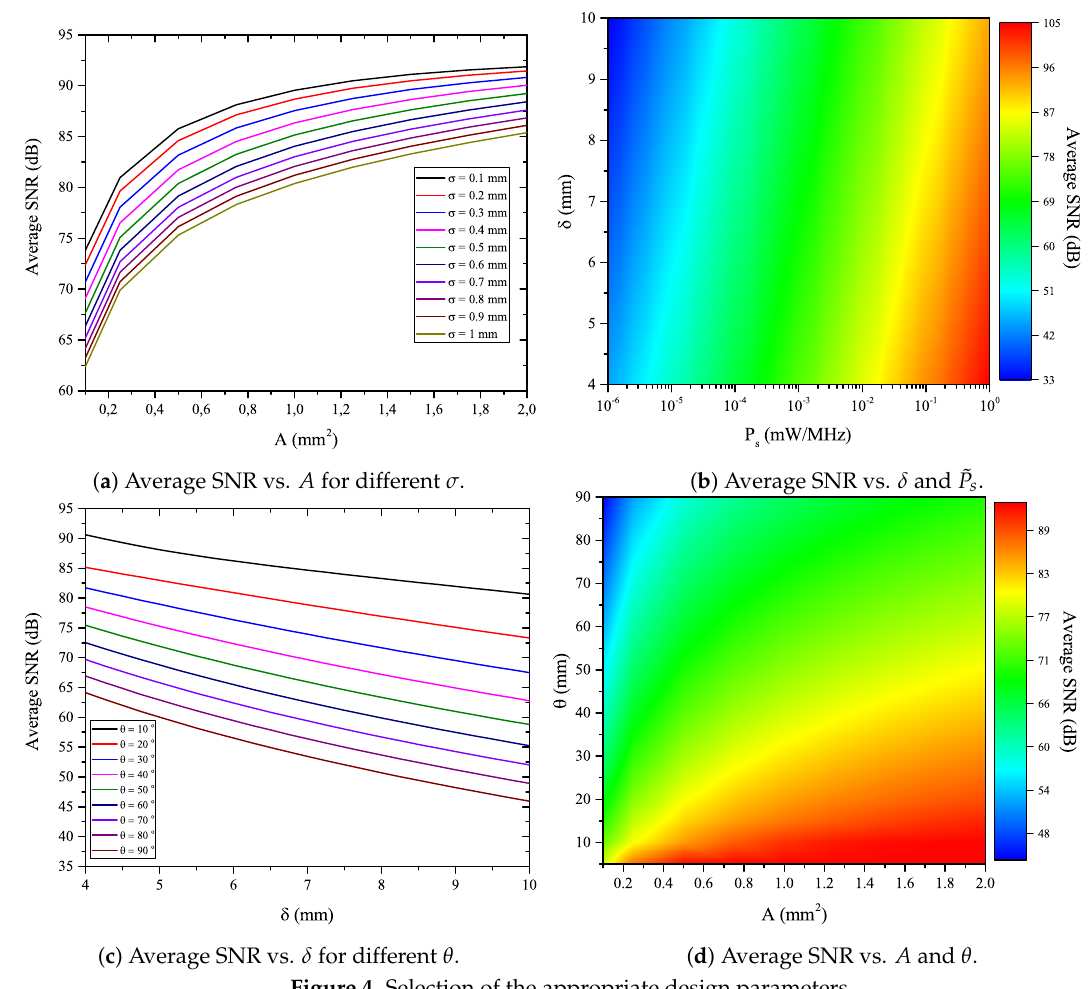
Figure 4. Selection of the appropriate design